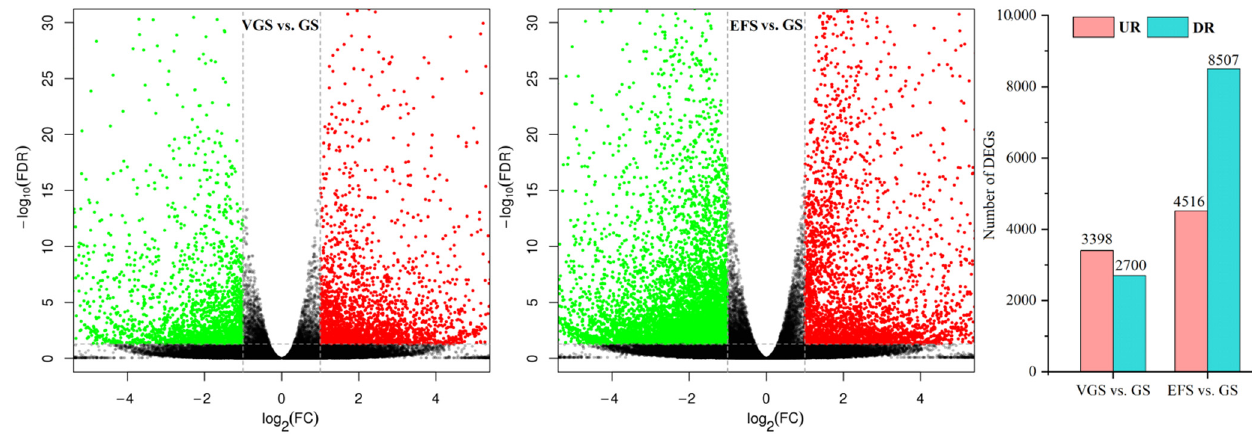
Figure 4. Volcano plot of unigenes and number of differentially expressed genes (DEGs) at VGS and EFS vs.